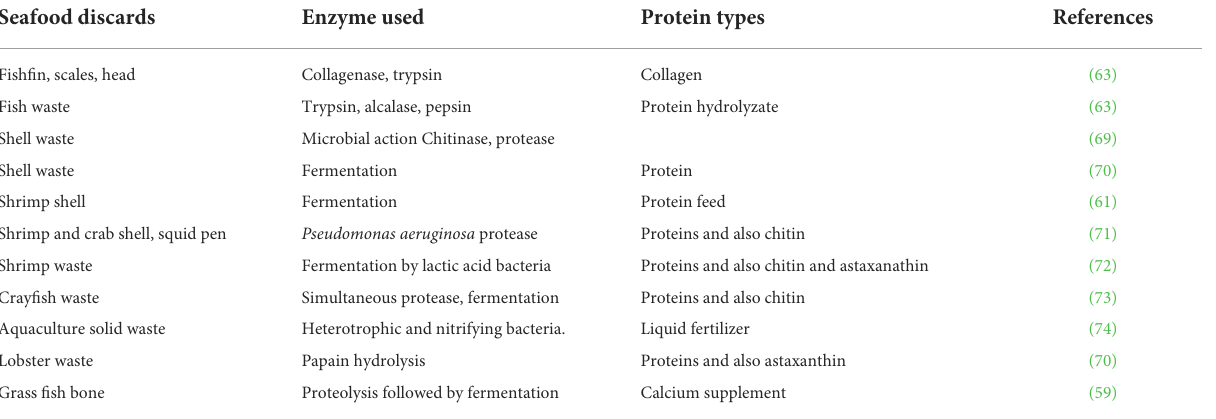
TABLE 2 Examples of fermentative and enzymatic extractions of proteins from seafood side streams. Seafood